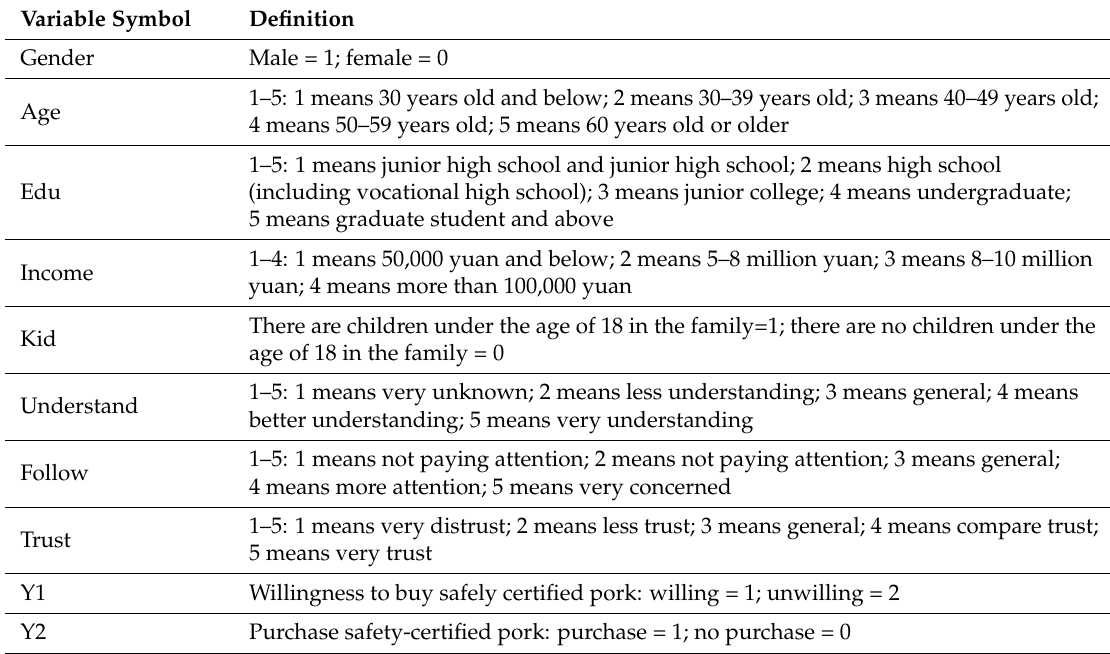
Table 6. The variable definition and description.